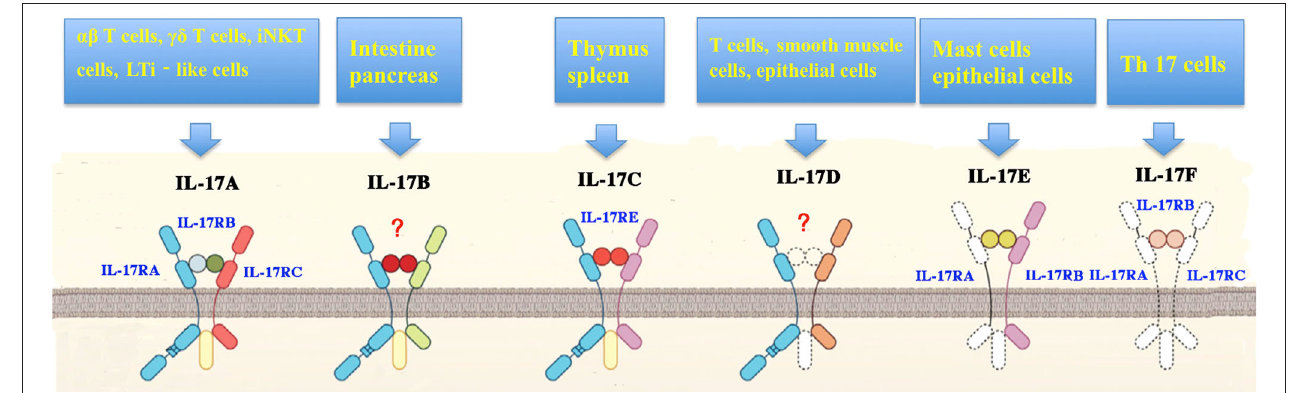
FIGURE 2 | Cellular sources and receptors of interleukin-17. Interleukin (IL)-17 family includes isoforms A to F. IL-17 can be induced by a variety of cells including T helper (Th) 17 cells, γδ T cells, natural killer T (NKT) cells, group 3 innate lymphoid cells (ILC3s), CD8 + (Tc17) cells, neutrophils, microglia, mast cells, myeloid cells in the lung and kidneys, and Paneth cells in the intestine. In addition, antigen-presenting cells (APCs) stimulate the production of IL-17in response to stress proteins, pathogen-associated molecular patterns (PAMPs), or microbial metabolites. IL-17 receptor (IL-17R) family is composed of IL-17RA, IL-17RB, IL-17RC, IL-17RE, as well as IL-17RA and C heterodimeric